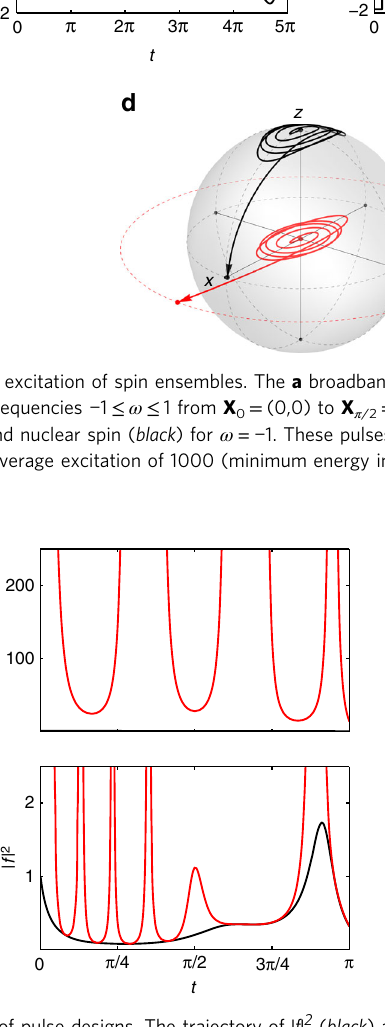
Fig. 3 Feasibility of pulse designs. The trajectory of | f | 2 ( black ) and the corresponding bound ( red ) given by the right side of Eq. (4) resulting from the a minimum-energy control u * π /2 and b a quadratic control, u ( t ) = (18 t 2 + 4 − 9 π 2 )/8, that steer the spring from X 0 = (0,0) to X π /2 = ( π /2,0). In a the trajectory of | f | 2 is much smaller than the bound, appearing as a horizontal line at the bottom of the fi